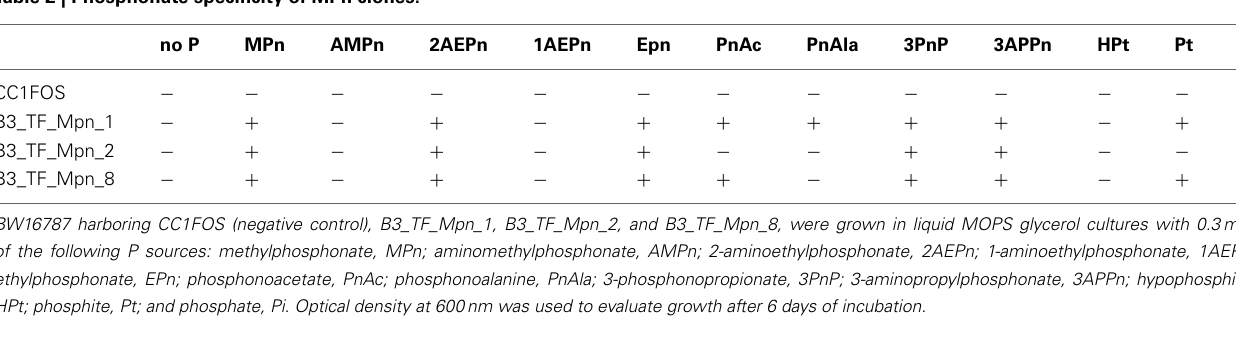
Table 2 | Phosphonate specificity of MPn